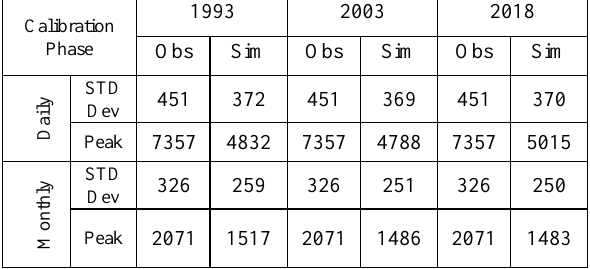
Table 20 Streamflow characteristics during calibration phase Validation Phase